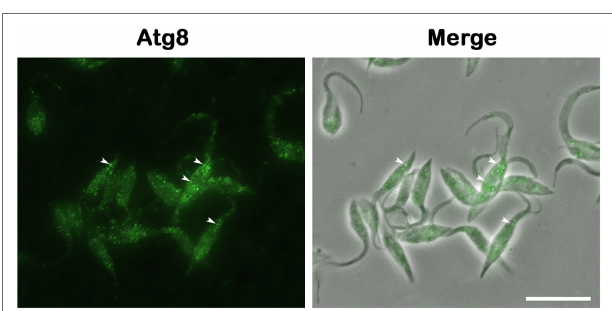
FIGURE 4 | Atg8 detection is the gold standard method for monitoring autophagy. Rabbit anti-TcAtg8 antibody was employed to reveal Atg8 puncta (arrowheads) in Trypanosoma cruzi epimastigotes. Secondary antibody: anti- rabbit Alexa 488. Bar = 10 μ